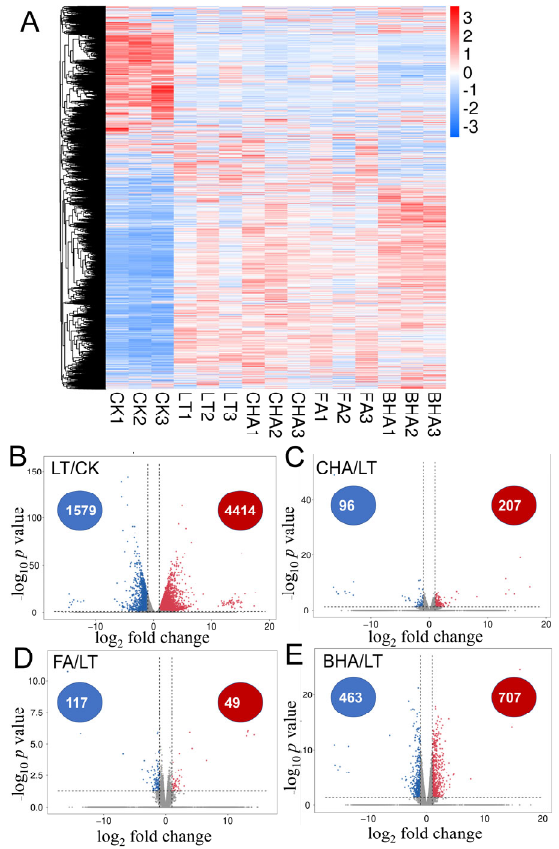
Figure 2. Transcriptomic analysis to determine the differentially expressed genes (DEGs) in the leaves of coal-based humic acid (CHA)-, fulvic acid (FA)-, and biochemical humic acid (BHA)-treated zucchini seedlings under LT stress. ( A ) Hierarchical clustering analysis of the transcriptome data. ( B – E ) Volcano map of DEGs. The scale represents log 10 (FPKM+1). ( B ) LT/CK comparison. ( C ) CHA/LT comparison. ( D ) FA/LT comparison. ( E ) BHA/LT comparison. The log 2 -fold change (FC) ≥ 1 or ≤ − 1 and FDR < 0.05. LT, 5 ◦ C. CHA, 5 ◦ C + 0.05% coal-based humic acid. FA, 5 ◦ C + 0.05% fulvic acid. BHA, 5 ◦ C + 0.05% biochemical humic